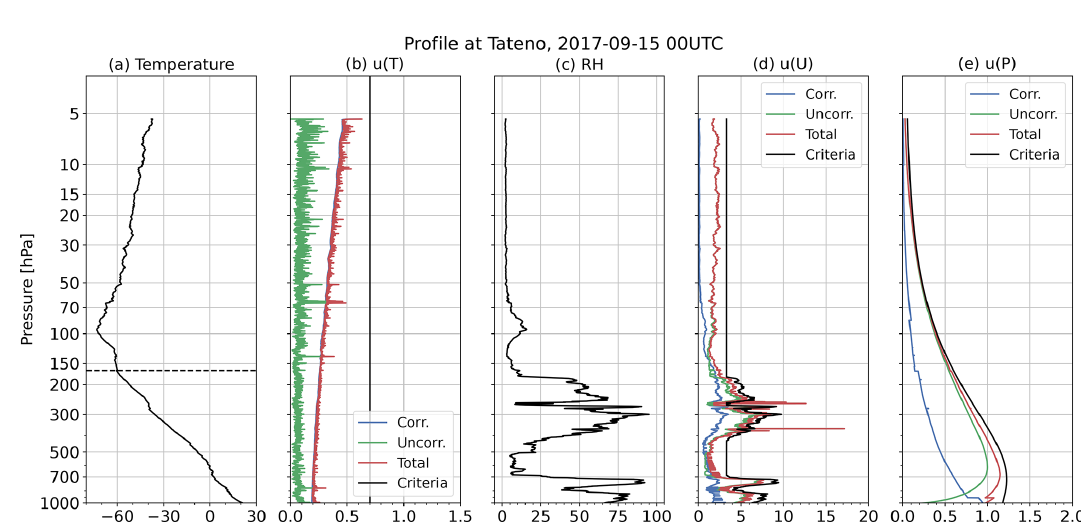
Figure 4. The profile of (a) temperature, (b) temperature uncertainty, (c) RH, (d) RH uncertainty, and (e) pressure uncertainty at 00:00UTC on 15 September 2017. The dashed line in panel (a) is the tropopause height. The blue, green, and red lines in panels (b) , (d) , and (e) are correlated, uncorrelated, and total uncertainty, respectively. Black lines in panels (b) , (d) , and (e) show the criteria for screening described in Sect.